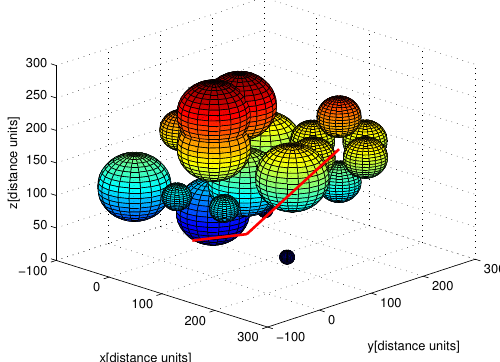
Figure 6. Highly cluttered environments. The path constructed utilizing one MC simulation of Algo- rithm 1. The obstacles are shown as spheres. The generated path is depicted with red line